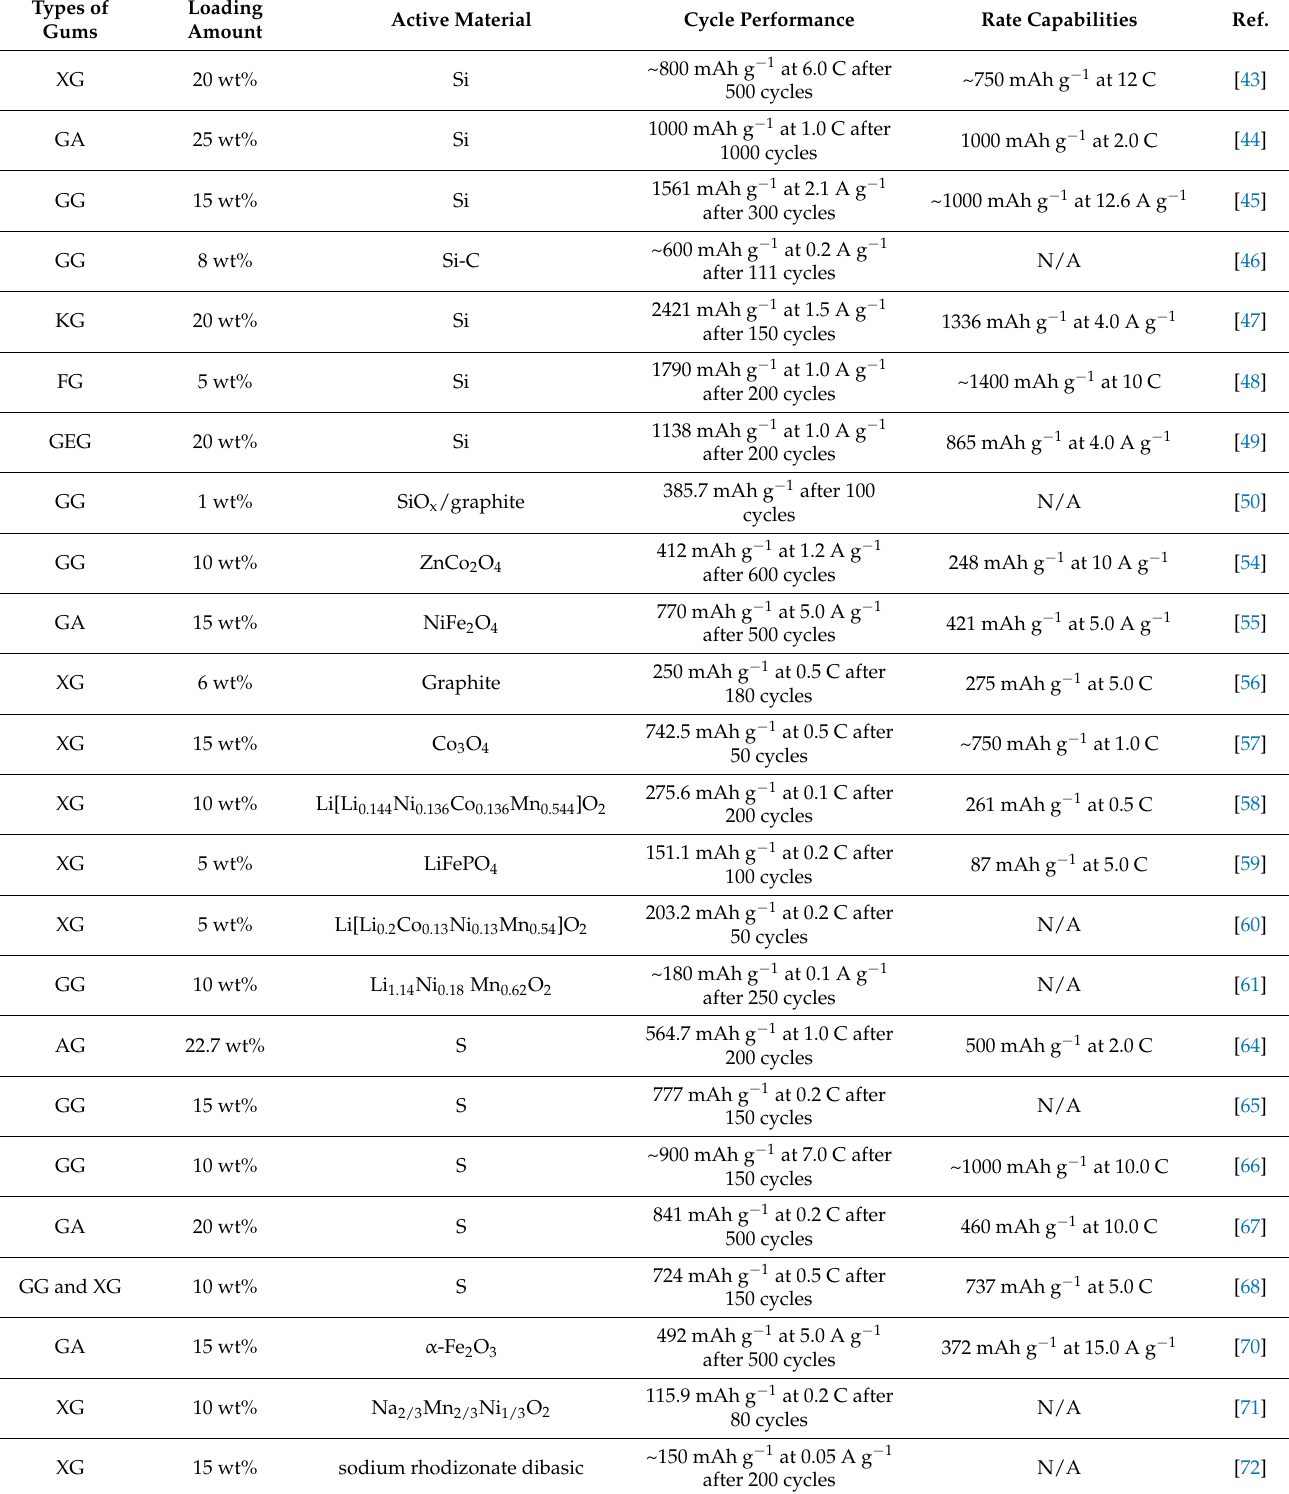
Table 1. Summary of electrochemical performance of rechargeable batteries based on natural gum- based